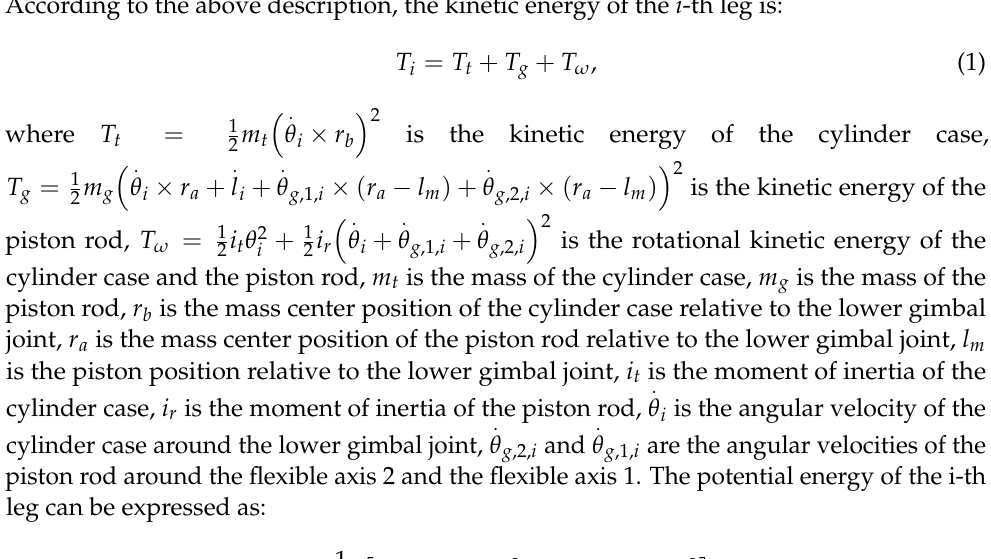
Figure 4. The schematic diagram of the i-th leg and the moving platform. Actually the phenomenon of flexible modes can be observed in parallel mechanisms with smooth joints and regular joints, so the friction of the joints and the gravity load are ignored in the modeling process, and due to the symmetry of the 6-DOF parallel mechanism, only one of the six hydraulic legs is needed to develop the equations of motion. According to the above description, the kinetic energy of the i -th leg is: